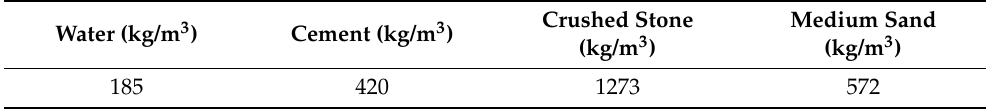
Table 1. Mixture ratio of the concrete.